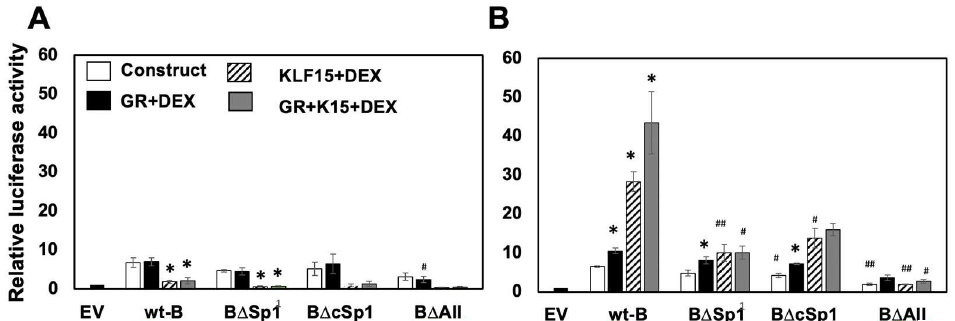
Figure 5. Transactivation of fragment B and mutants by GR, KLF15, and/or DEX. Neuro-2A ( Panel A ) or Vero ( Panel B ) cells were incubated in 2% stripped FBS and transfected with 0.5 ug of the denoted B constructs and a Renilla luciferase plasmid (0.05 ug). Denoted samples were co-transfected with GR (1 ug) and/or KLF15 (0.5 ug) expression plasmids. Empty vector (pGL4.24[luc2P/minP]) was added to cultures to maintain the same DNA concentration. 24 h after transfection, certain cultures were incubated with water-soluble DEX (10 uM). Cells were harvested at 48 h, and dual luciferase assay was performed. Luciferase activity was calculated relative to empty vector luciferase activity. Results are the mean of three experiments, and error bars indicate standard error. An * denotes a significant difference compared to the luciferase construct alone. A # denotes a significant difference in the denoted mutant construct relative to the respective wt B transfected samples. A */# denotes a significant difference of p < 0.05, whereas a ## denotes a significant difference of p < 0.005, as determined by Student’s t -test. Statistical analysis was performed as described in Materials and